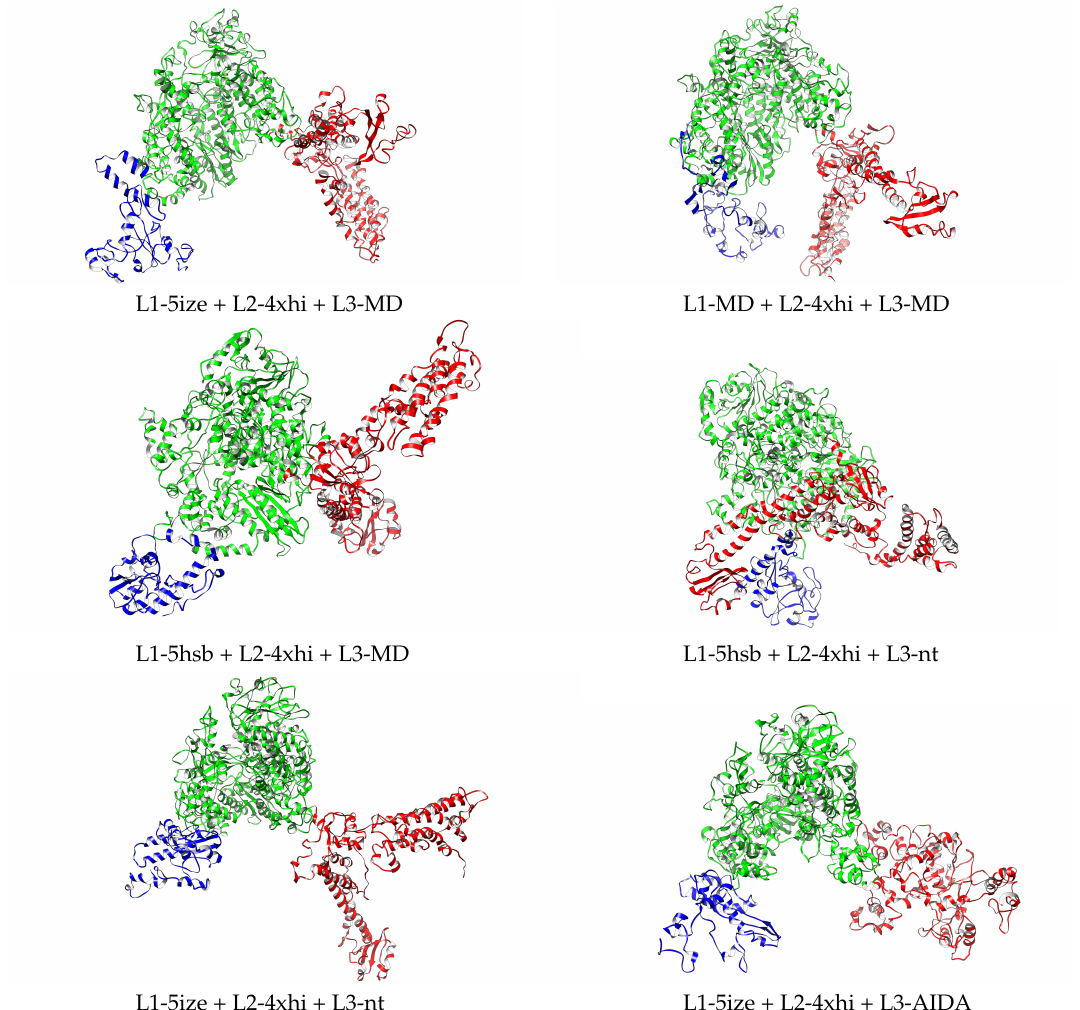
Figure 4. Relaxed structures corresponding to the MP score before and after relaxation in Table 3. L1, L2, and L3 domains depicted in blue, green, and red, respectively. Drawn with Chimera